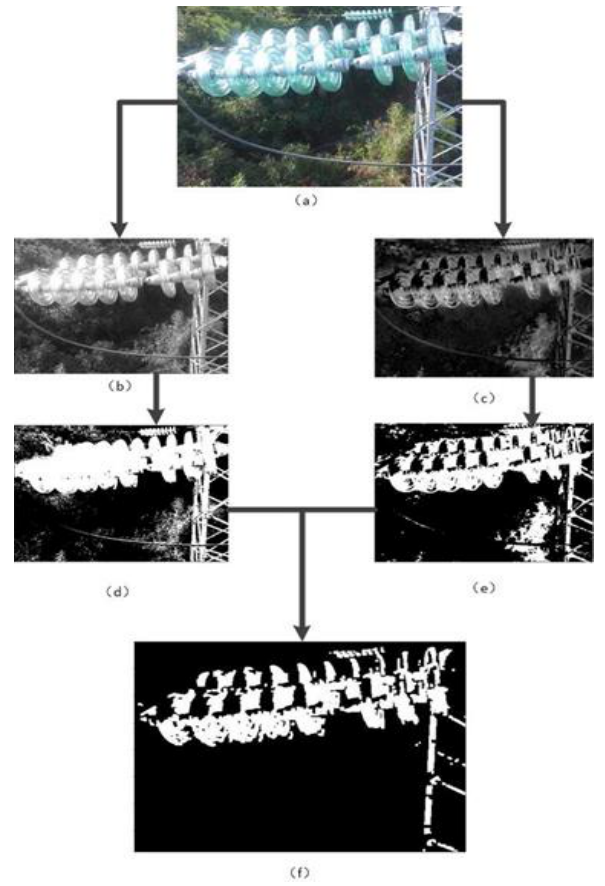
Figure 3. The process of obtaining similar areas of insulators. ( a ) Reduced insulator inspection image, ( b ) grayscale insulator detection image, ( c ) “RB color” feature insulator detection image, ( d ) binary image for gray-level threshold segmentation, ( e ) binary image for “RB color” feature image threshold segmentation, and ( f ) binary image representation of the insulator feature image.